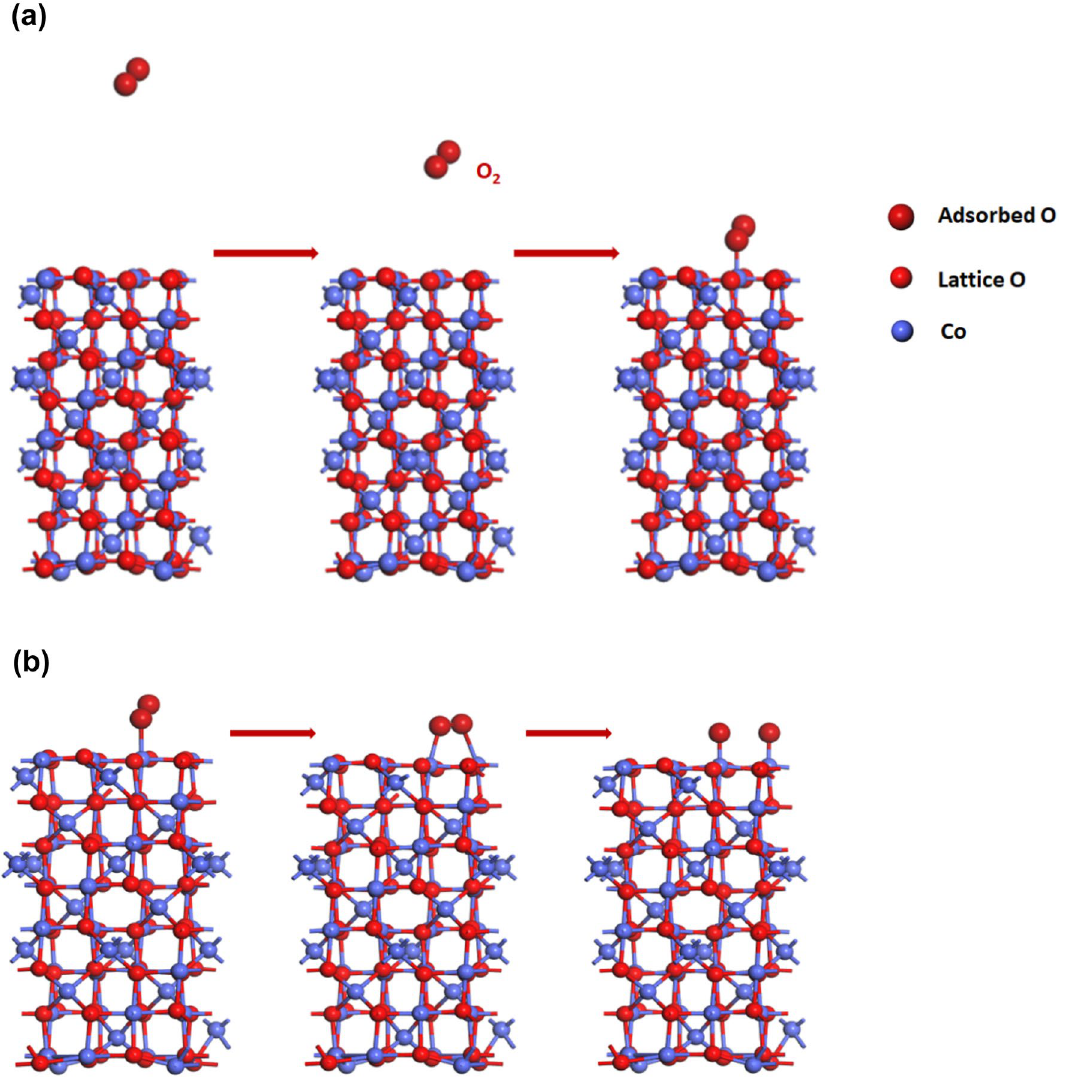
Fig. 1 Schematics for a oxygen adsorption and b oxygen dissociation on Co